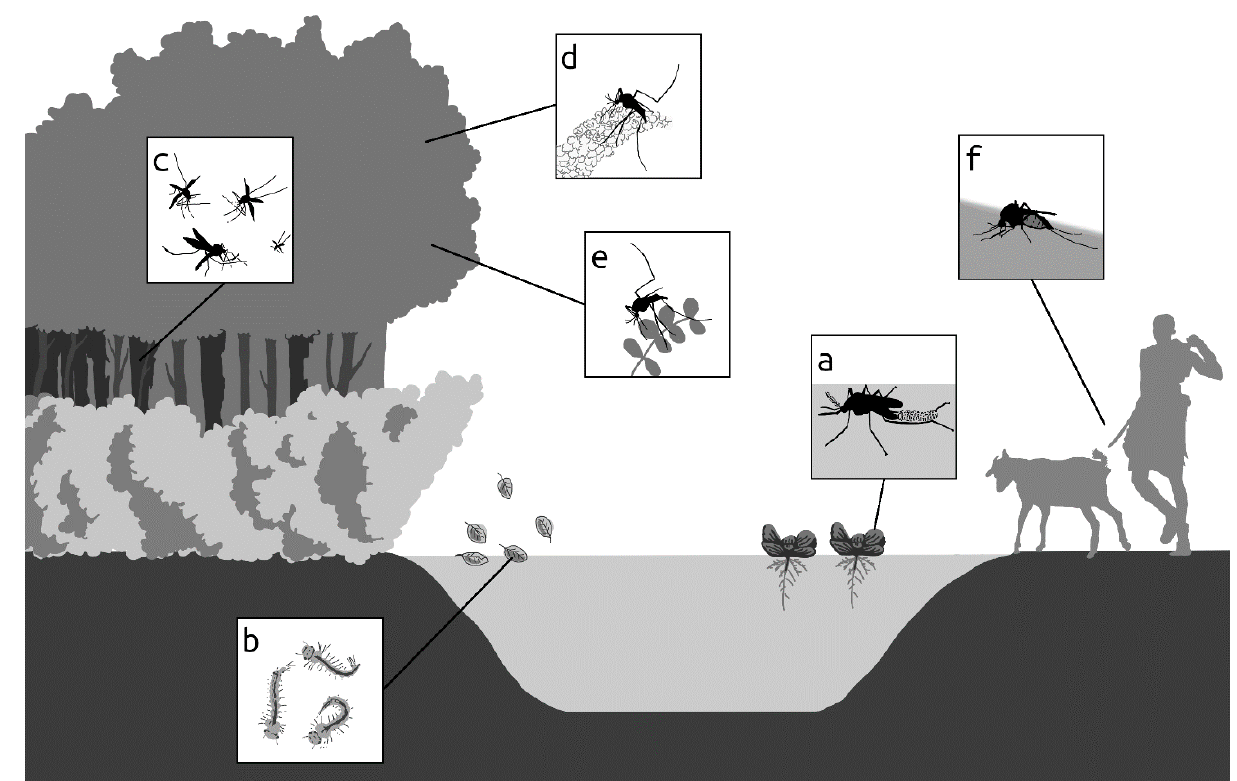
Figure 1. Potential effects of invasive plants on mosquito life-history traits. ( a ) Invasive plants offer suitable oviposition sites for some vector species; ( b ) invasive plant litter increases proliferation of immature vectors; ( c ) dense canopy cover or thickets of invasive plants provide suitable micro-habitats for adult mosquitoes; ( d ) nectariferous flowers ( e ) and extra-floral glands of invasive plants are important sugar sources for adult vectors; ( f ) invasive plants can influence the pathogen transmission ability of the vector. (designed by Miguel